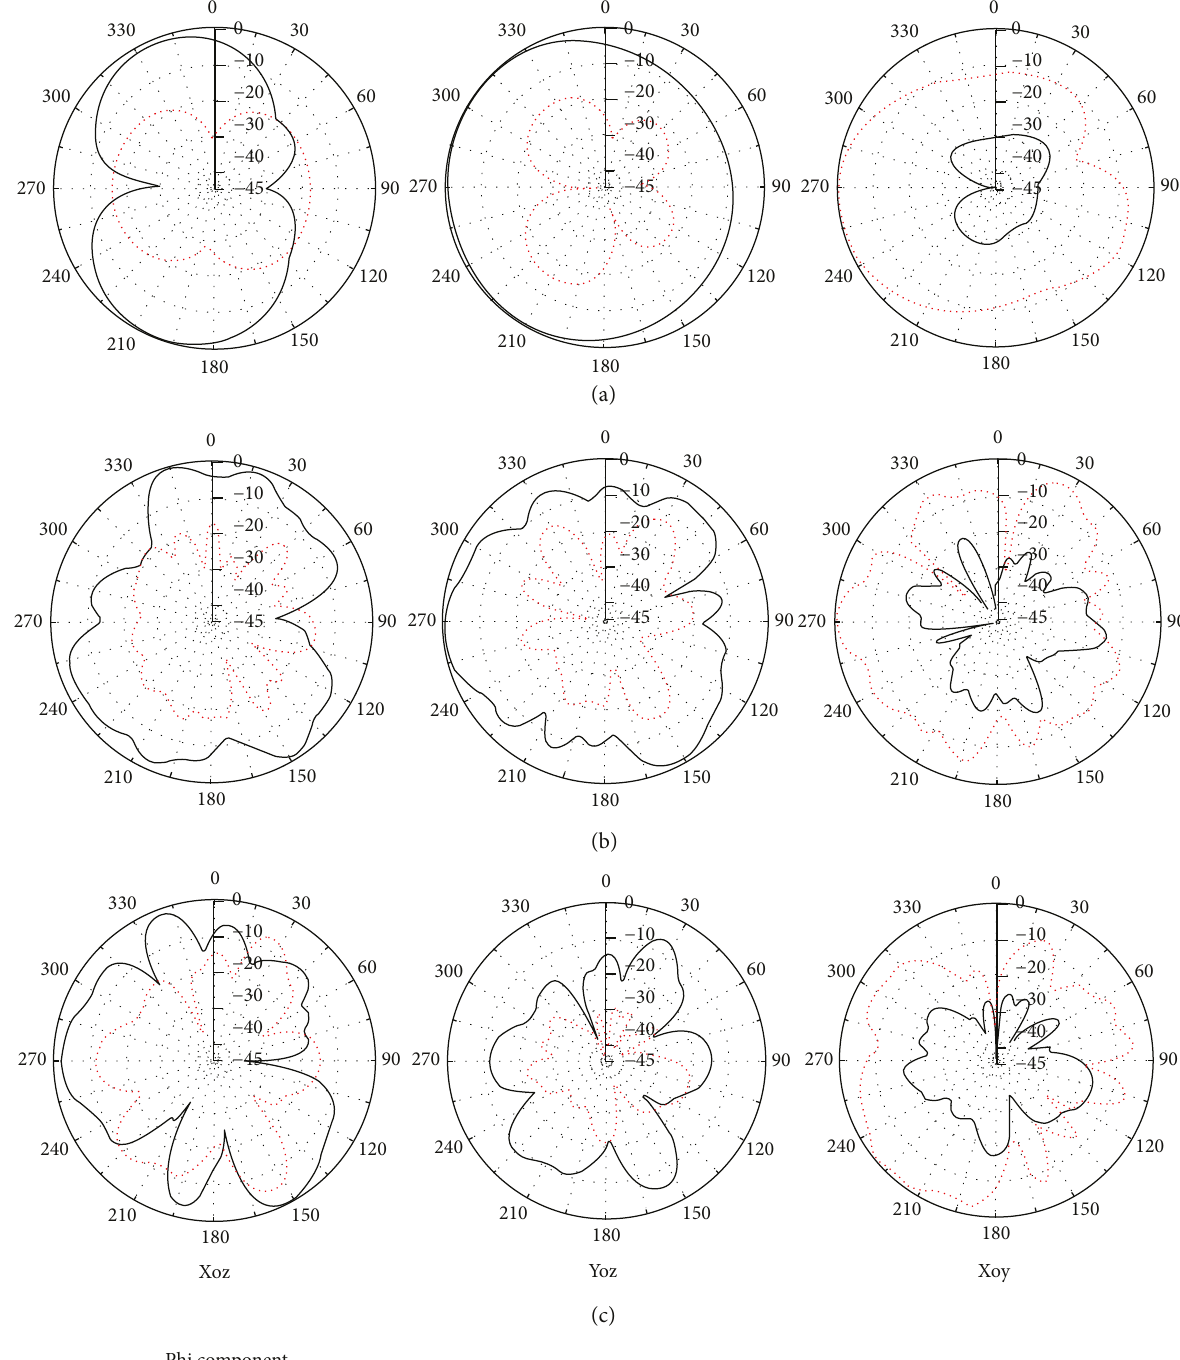
Figure 8: Measured radiation pattern of the proposed antenna at (a) 3.5, (b) 10.5, and (c) 16.2GHz (at two planes of xoz and yoz, where theta component is coplanar radiation pattern; and at xoy plane, where phi component is coplanar radiation